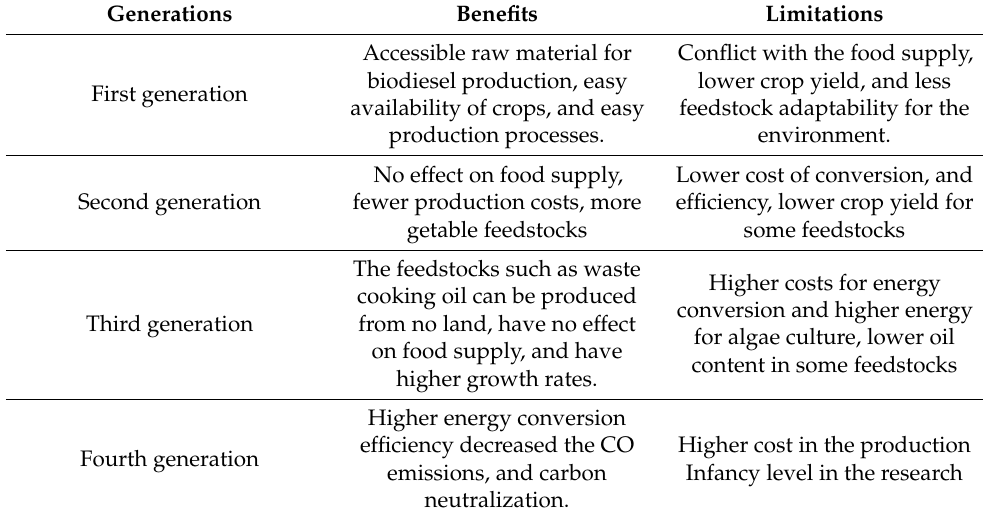
Table 7. Benefits and Limitations of different generations of biodiesel [163,164]. Generations Benefits Limitations Conflict with the food supply, Accessible raw material for lower crop yield, and less biodiesel production, easy First generation feedstock adaptability for the production processes.